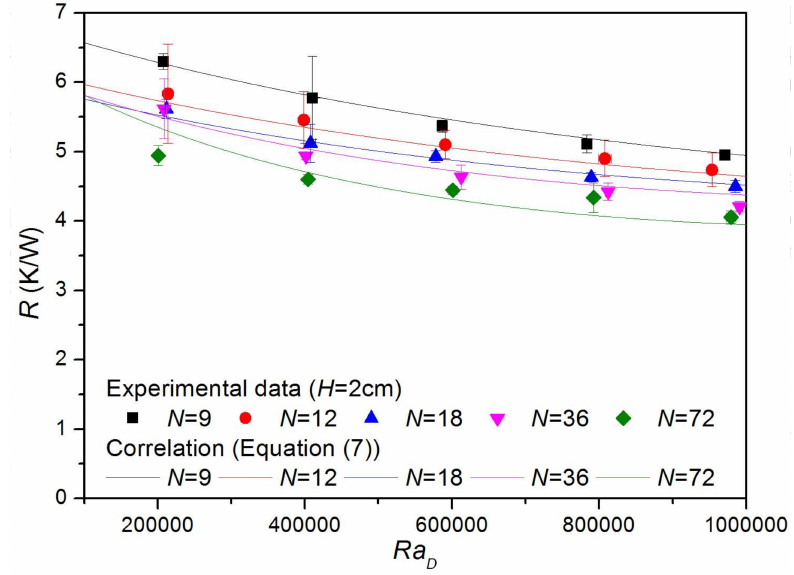
Figure 10. Thermal resistances for various fin numbers.